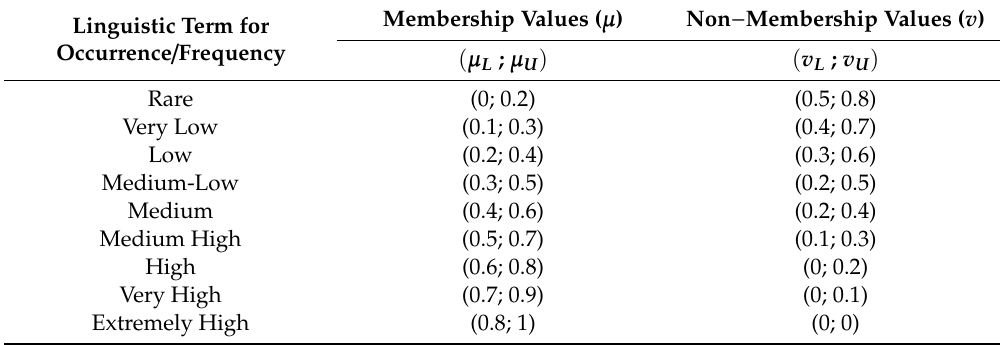
Table 6. Linguistic Terms for Occurrence / Frequency with Corresponding IVIFs (Adapted from